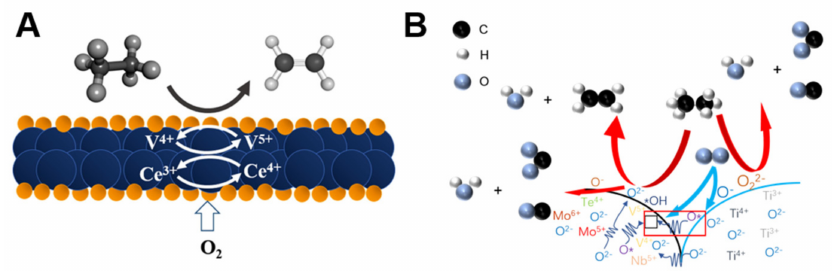
Figure 17. ( A ) The combination of M1 MoVNbTeO x with CeO 2 . ( B ) M1 MoVNbTeO x /TiO 2 nano- composite catalysts with an effect on enhancing the redox properties during the ODHE process. Adapted from ref. [23,28], Copyright (2018), (2022), with permission from Elsevier and Royal Society of